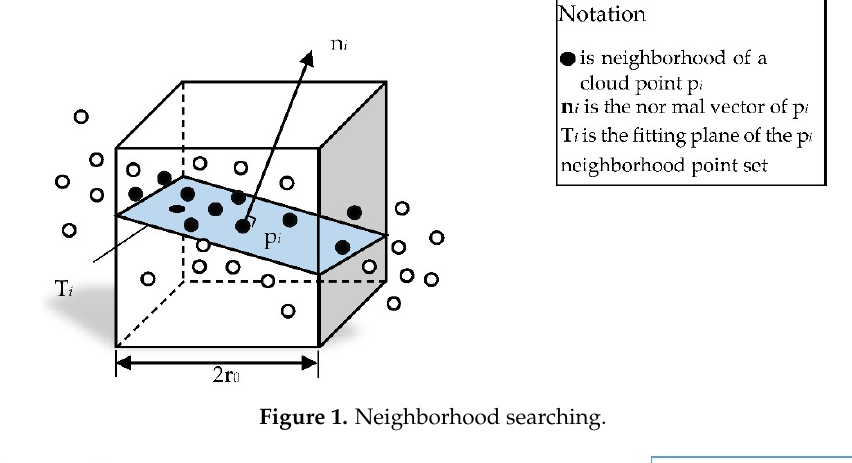
Figure 1. Neighborhood searching.